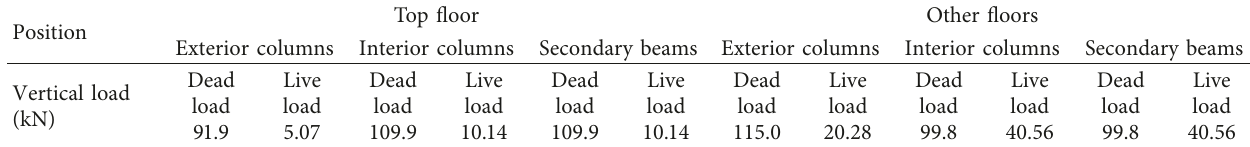
Table 2: Vertical load values and positions of the frame.